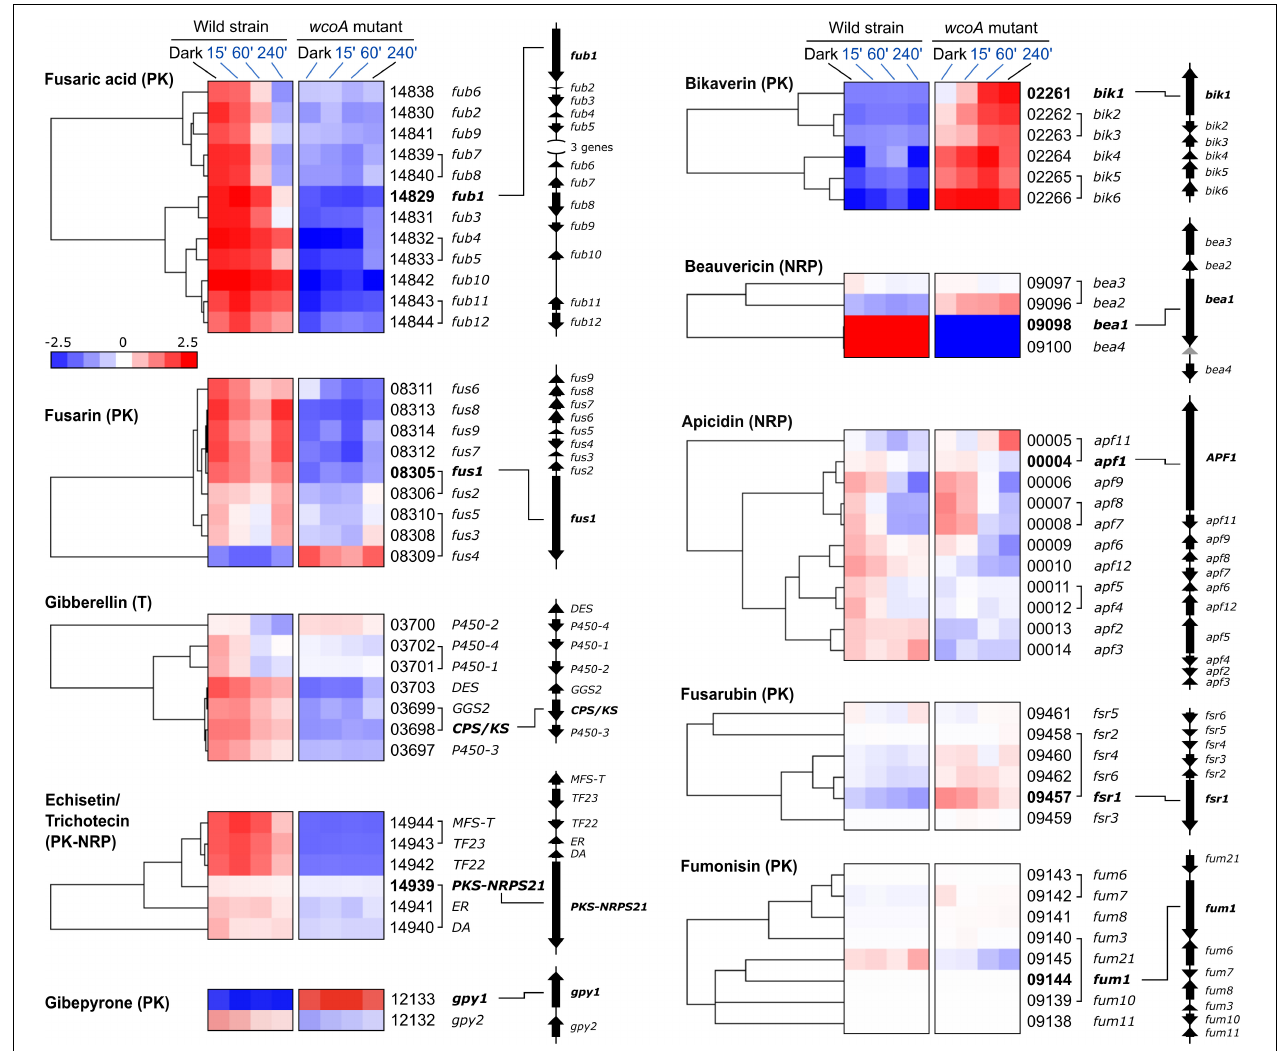
FIGURE 6 | Effect of illumination and/or the wcoA mutation on the mRNA levels of the genes of the indicated SMs. Data are shown as hierarchical heatmaps. FFC1_ numbers of the genes and names given in the literature, are indicated on the right, together with their genomic organizations. Genes divergently transcribed are joined with a bracket. The most relevant gene in the biosynthetic pathway is indicated in bold